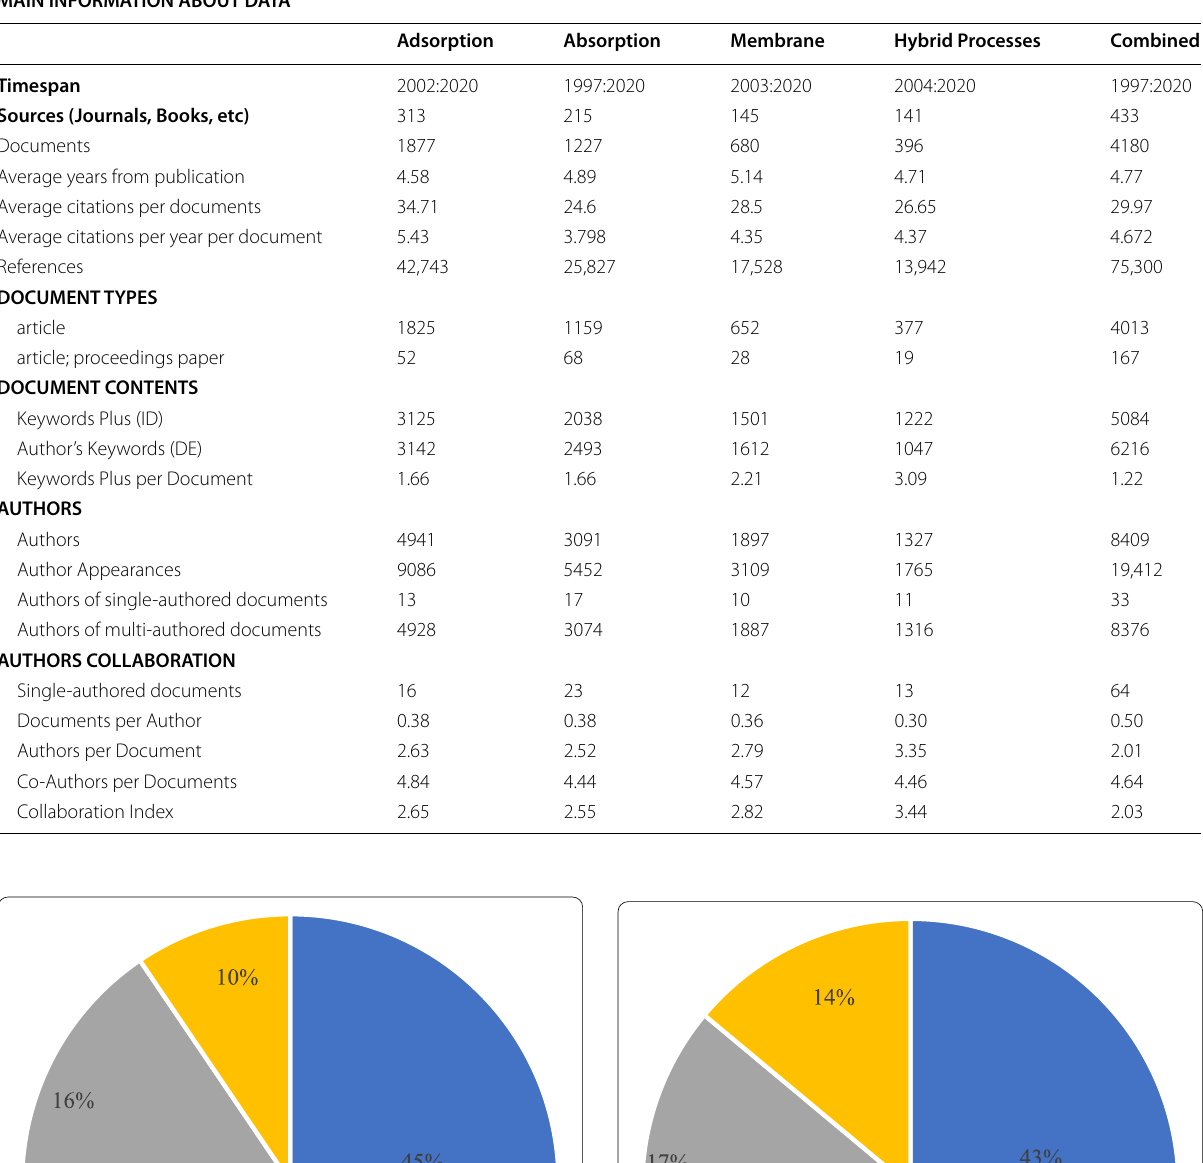
Table 2 Summary of the main information about the